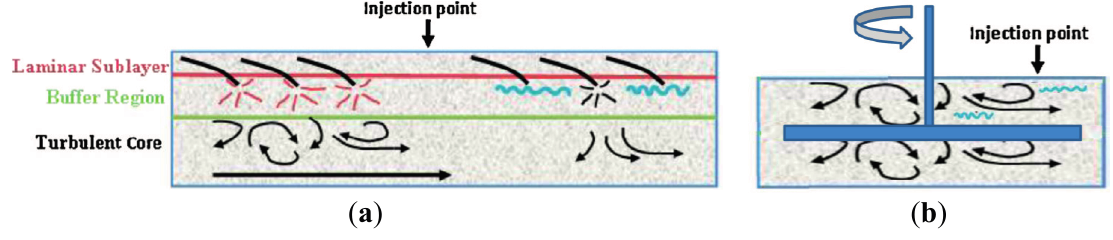
Figure 1. Schematic diagram for the methods of added polymer to solution with ( a ) pipeline turbulent flow (Reprinted from [3]) and ( b ) rotating disk apparatus (RDA) turbulent